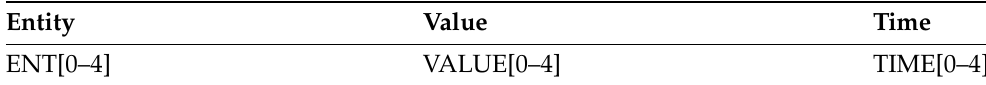
Table 2. Slot types and